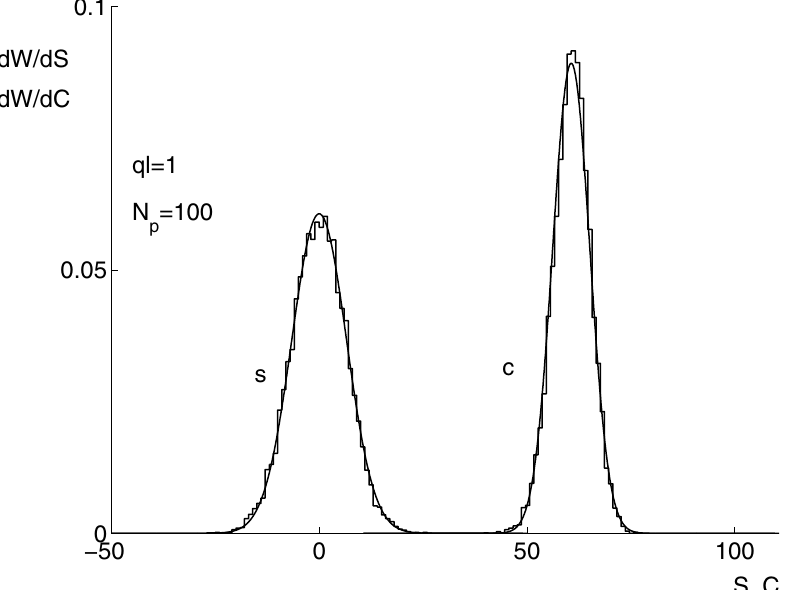
FIG. 4. A comparison of the analytical and numerical calculations for distributions (91) and (92). The curves s and c are given for distributions dW=dS (91) and dW=dC (92), respectively, at ql (cid:7) 1 , N calculations for distribution of S and C defined in (89) for 10 4 various sets of random numbers f z